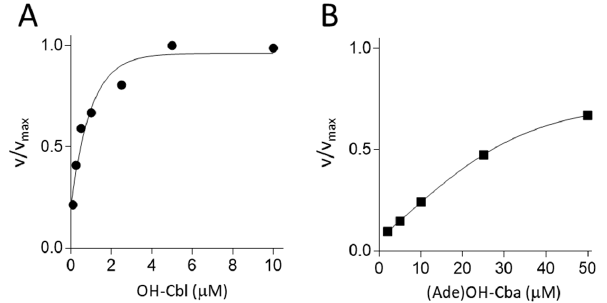
Figure 4. Effects of various concentrations of OH-Cbl ( A ) or (Ade)OH-Cba ( B ) on MS activity in MS cDNA-transfected cells. A cell homogenate of MS cDNA-transfected cells grown without OH-Cbl was used as an apo-MS preparation. MS activity was assayed in the reaction mixture containing various concentrations of OH-Cbl (0.1, 0.25, 0.5, 1, 2.5, 5, and 10 µM) or (Ade)OH-Cba (2, 5, 10, 25, and 50 µM).